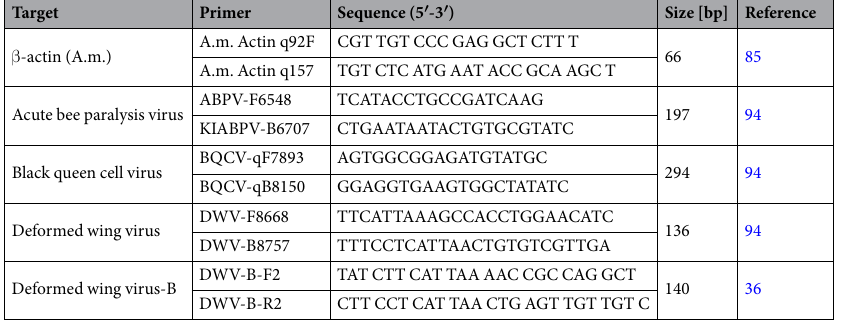
Table 1. Primers used for the quantification of honey bee viruses by qPCR assays. The targets, primer names, sequences, the product size and references are